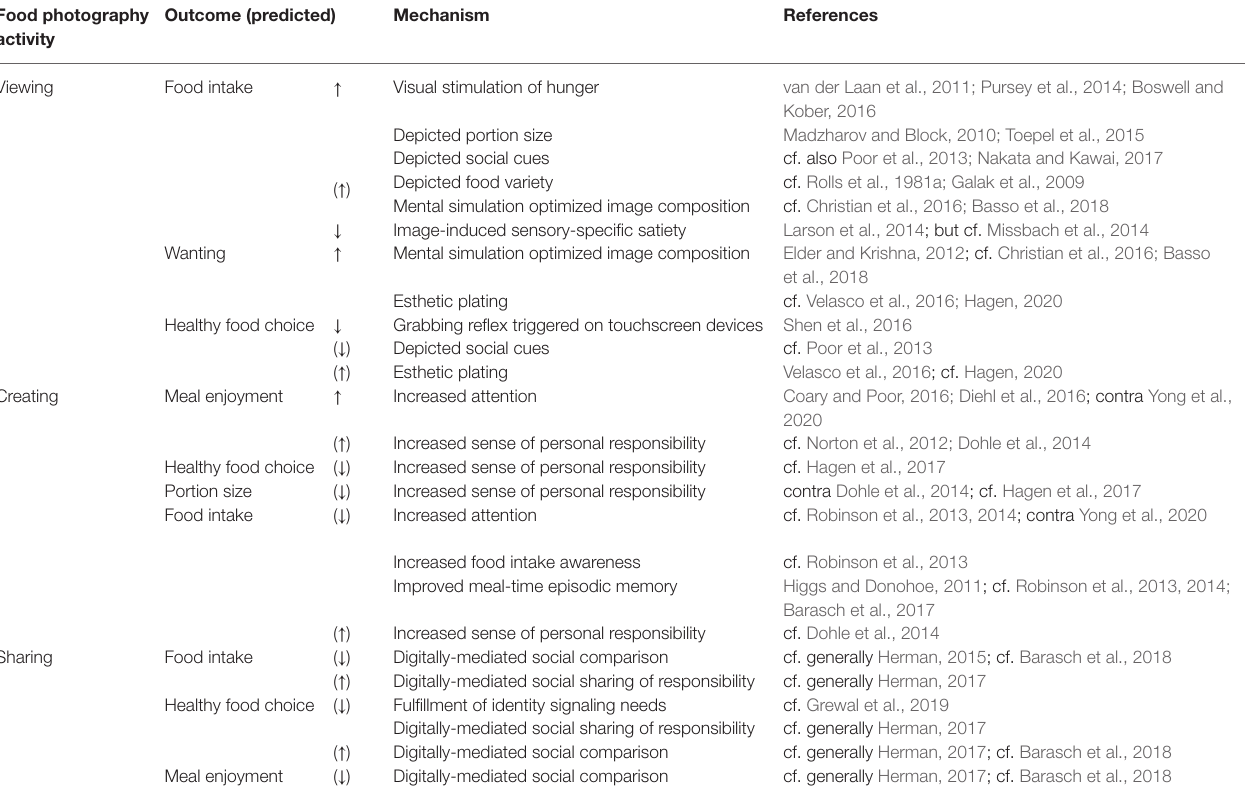
TABLE 1 | Published research of digital food habits, mediating mechanisms, and their (predicted) effects on eating behavior. Food photography